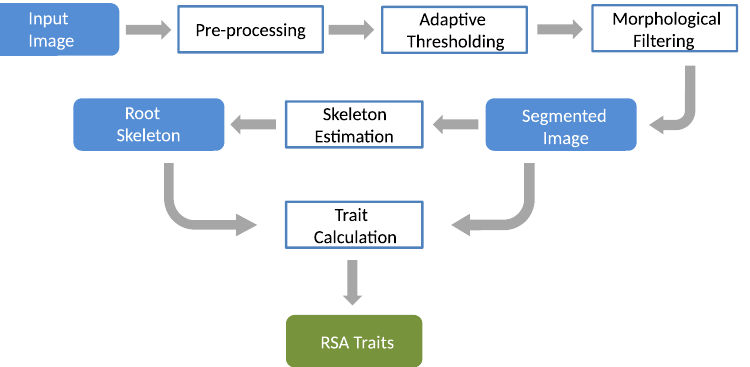
Figure 4. Work flow of image processing and analysis in saRIA. Color filled icons indicate the data modalities, framed rectangles describe image processing